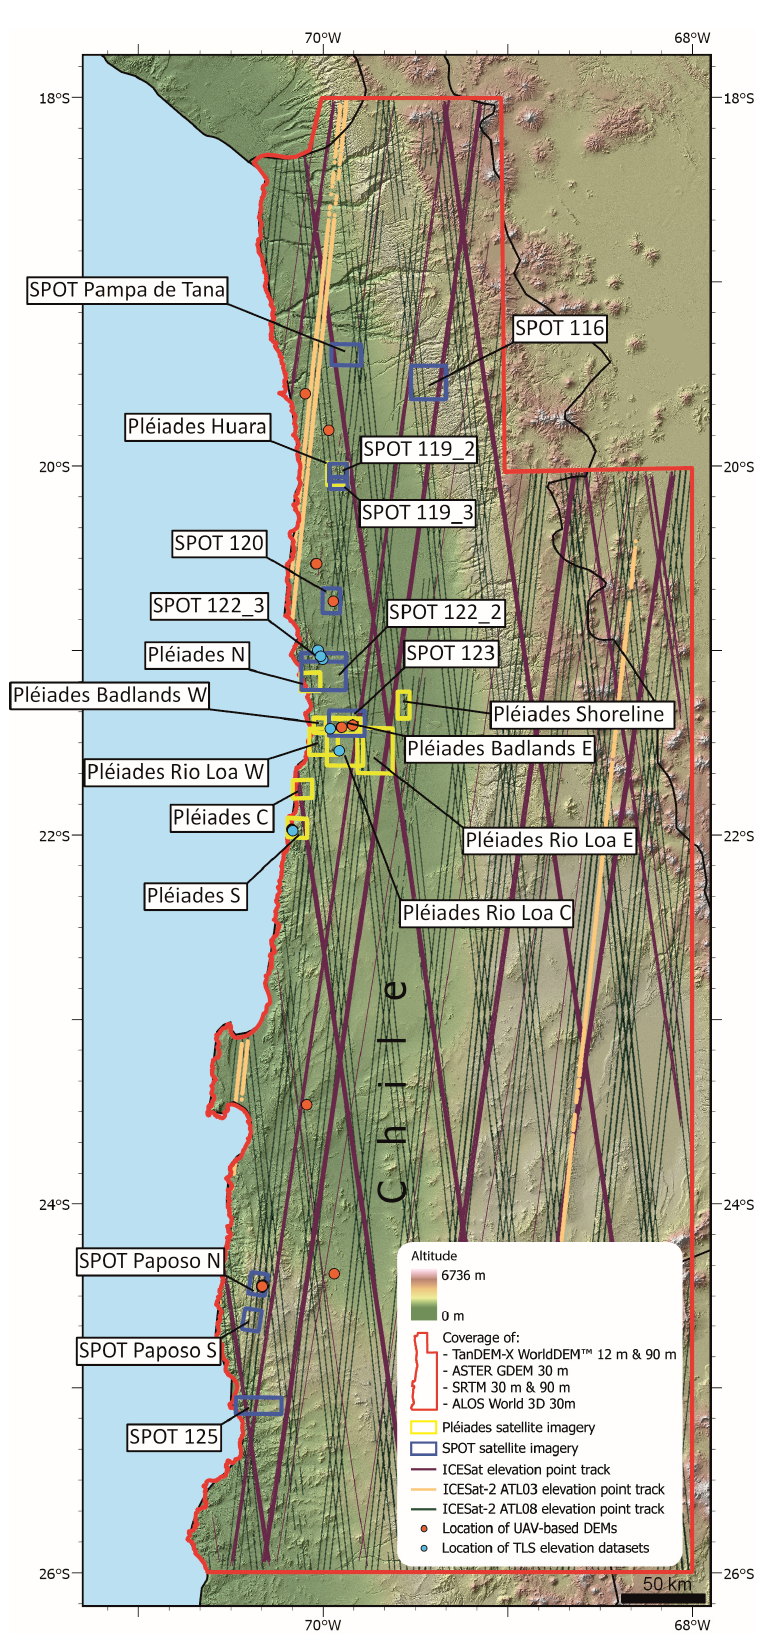
zebra stone stripes, described as contour-parallel bands of dark gravels with contrasting bands of fine-grained soil [68].